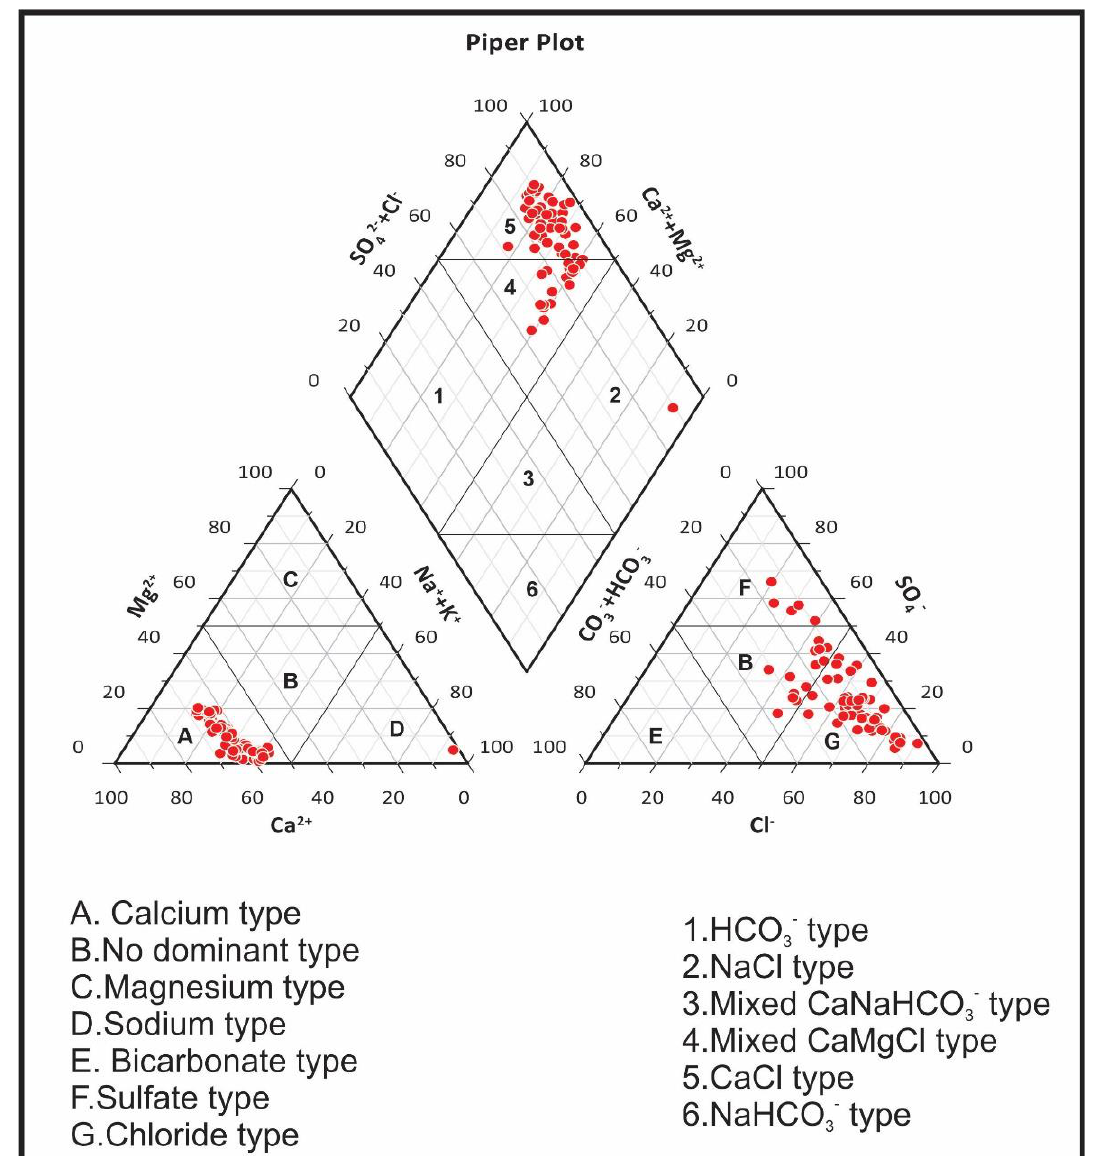
Figure 5. Piper diagram of groundwater samples from the study area.